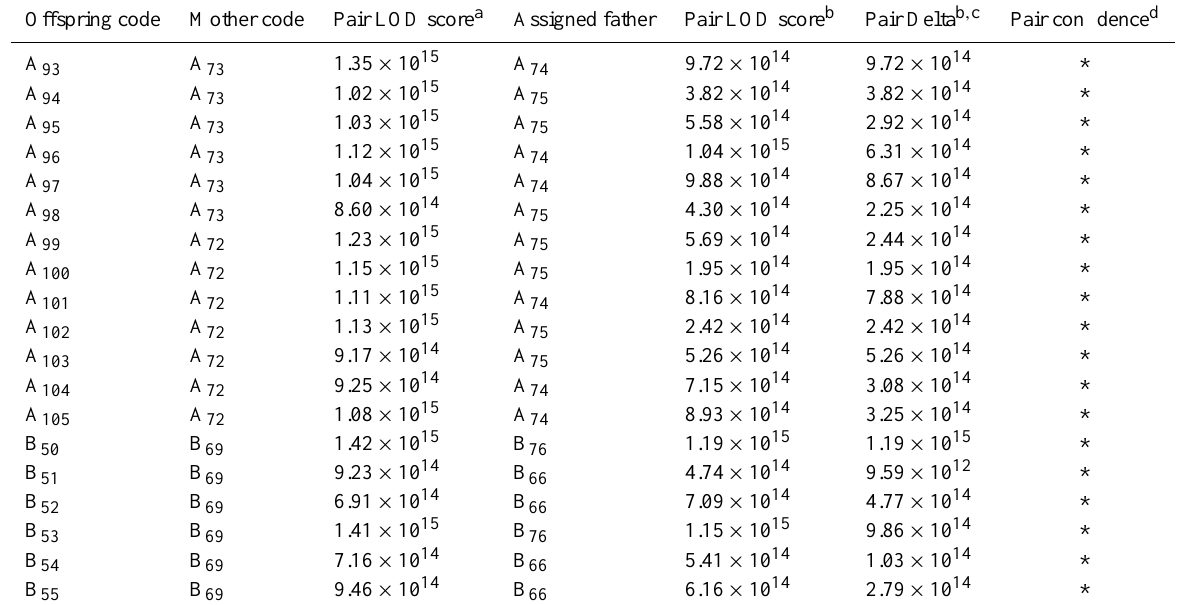
Table 2. Results of paternity assessment obtained using the program CERVUS. The assigned fathers are those with higher LOD score. Offspring code Mother